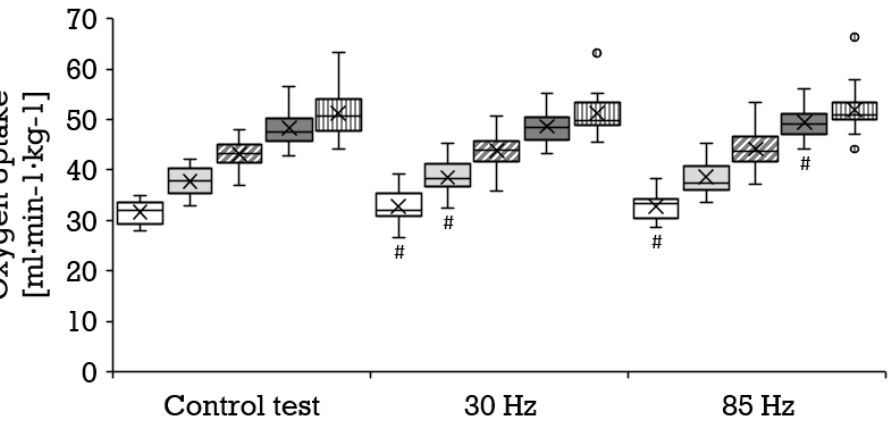
Figure 2. Distribution of the oxygen uptake (mL · min − 1 · kg − 1 ) depicted as boxplot at the stages 8 km/h (white box, n = 17), 10 km/h (bright gray box, n = 20), 12 km/h (diagonally striped box, n = 20) and 14 km/h (dark gray box, n = 17), as well as for the maximum values (vertically striped box, n = 17) during the control test, running with 30 Hz and running with 85 Hz. Each filled circle is representing a discordant value. Significances ( p < 0.05) compared to the control test are labeled with #.